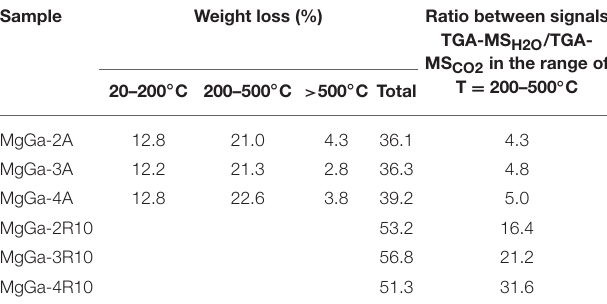
TABLE 2 | The results of thermal analysis for the studied MgGa hydrotalcites.